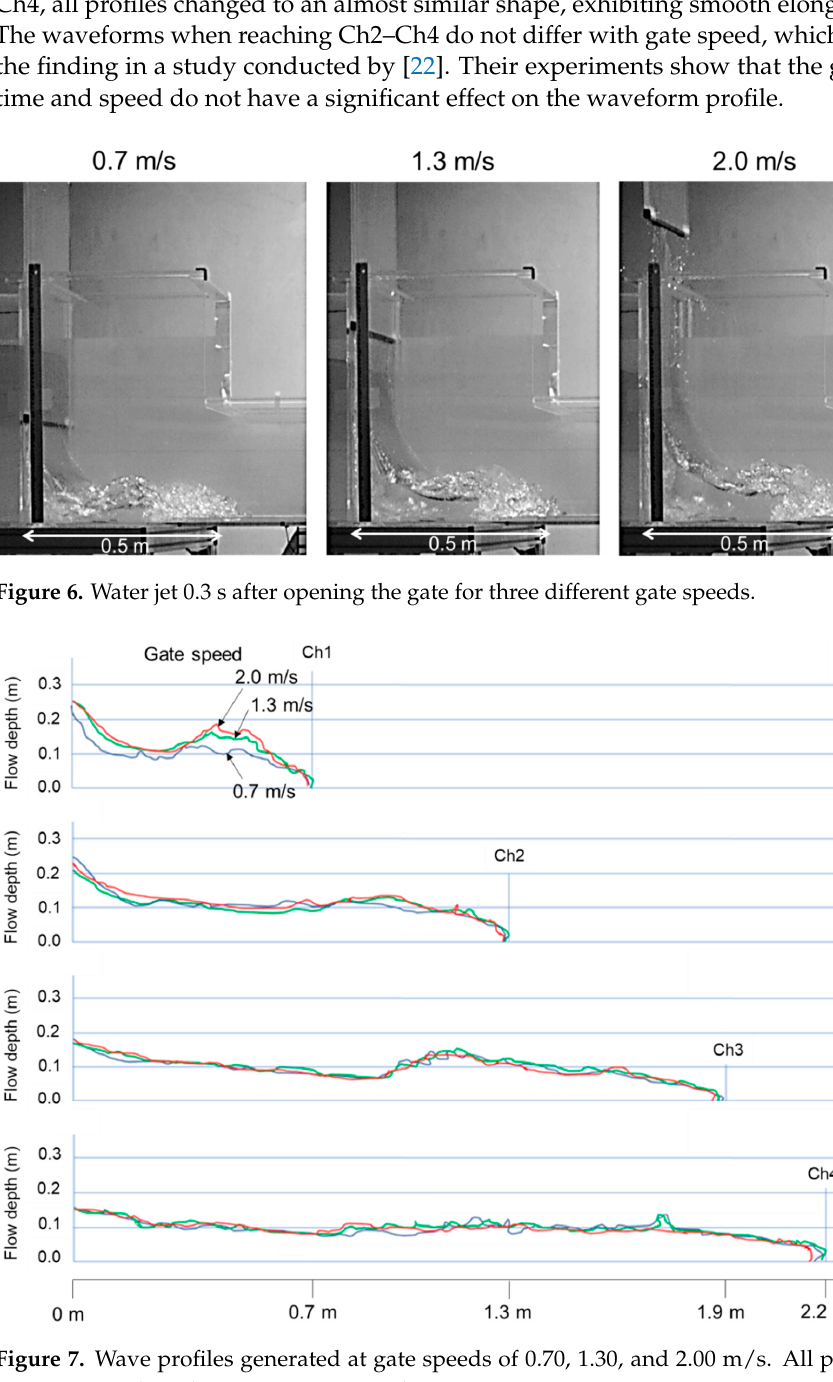
Figure 7. Wave profiles generated at gate speeds of 0.70, 1.30, and 2.00 m/s. All profiles tend to become smooth as the wave propagates downstream.